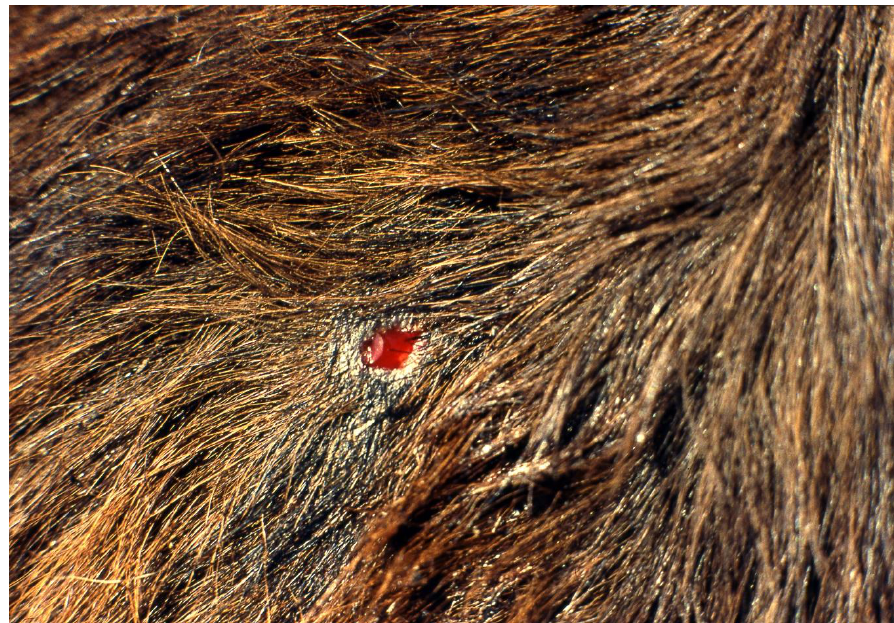
Figure 1. A typical lesion after a feeding bite of the common vampire bat on cattle. In a single bite, the vampire bat removes a piece of skin ~6 mm, exposing the subcutaneous tissue of the prey, and licks the blood. The anticoagulants in the bat’s saliva facilitate the maintenance of bleeding during feeding.